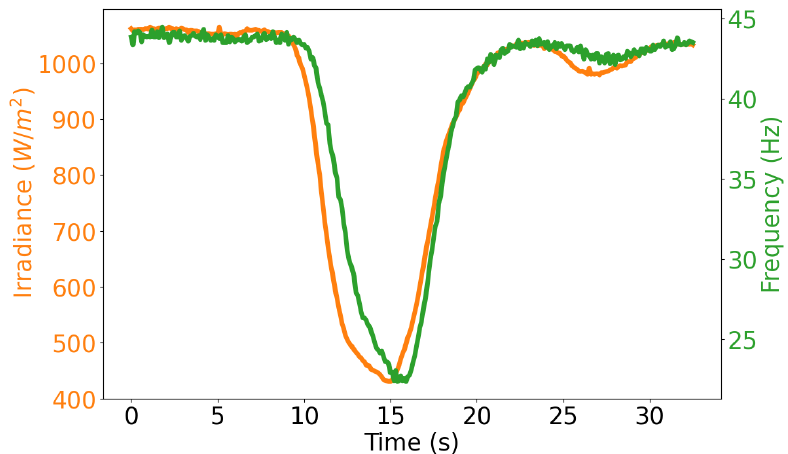
Figure 6. Cloud 2: Similarity of irradiance and frequency response